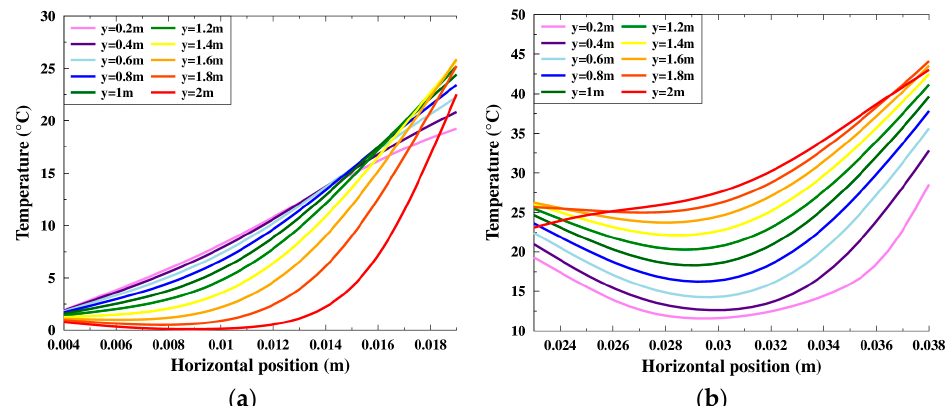
Figure 4. Variation in horizontal temperature profiles with VSW height: ( a ) outer air gap; ( b ) inner air gap.